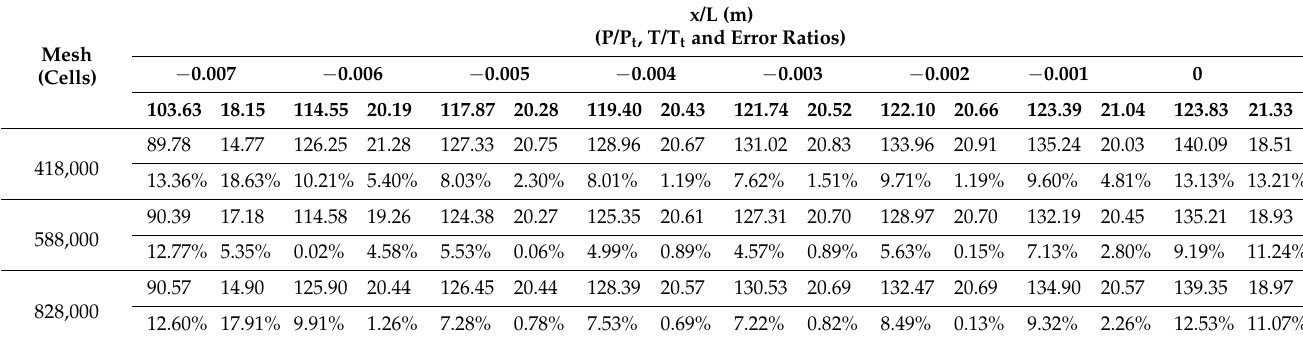
Table 2. Three different level meshes with error ratios at a far-field distance of 16 m for grid independency.